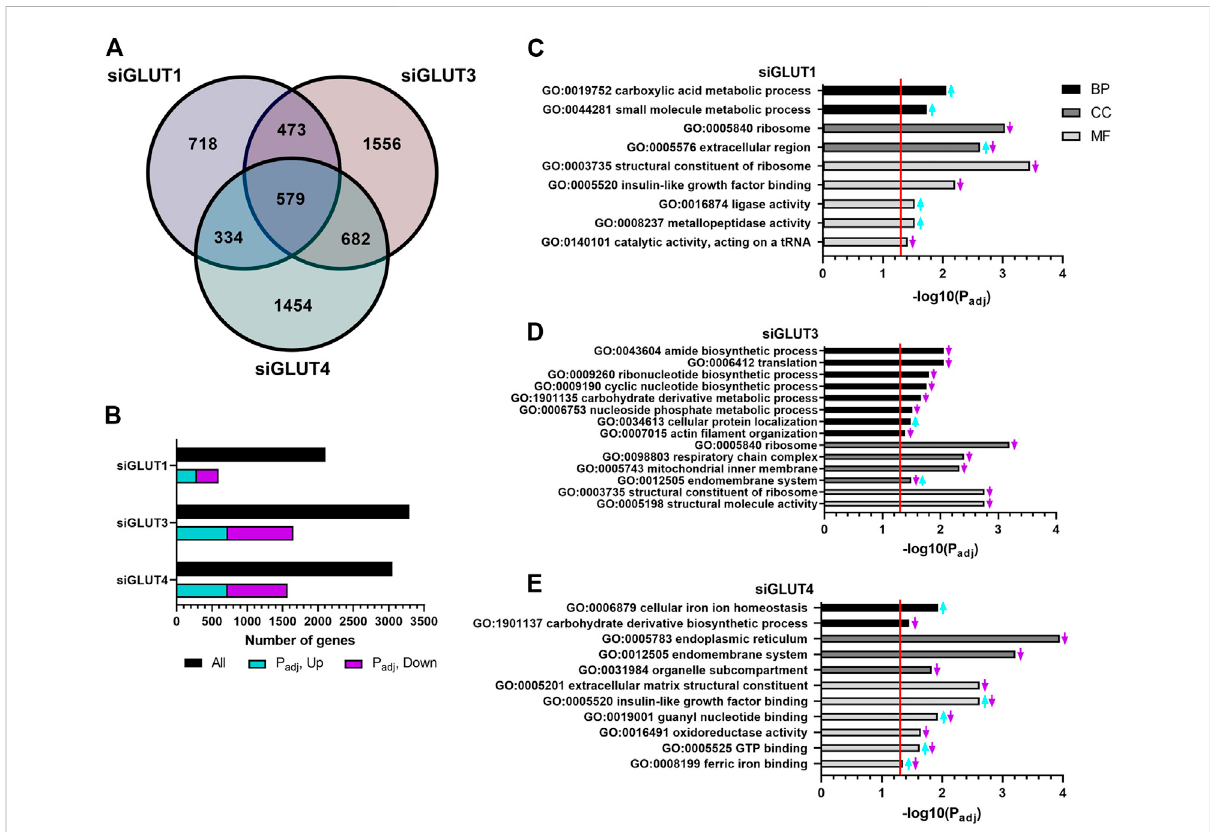
FIGURE 5 RNA sequencing of silenced cells reveals unique changes in gene expression. GLUT-silenced cells were compared to scramble control at 48 h post transfection and number of differentially expressed (DE) genes in each group are shown in Venn diagram (A) . Number of up- and down- regulated DE genes after p -value adjustment (B) . Functional analysis of DE genes (p adj < 0.05) in GLUT1 (C) , GLUT3 (D) , and GLUT4 (E) silenced cells was done by common pathway enrichment analysis referencing to Gene Ontology